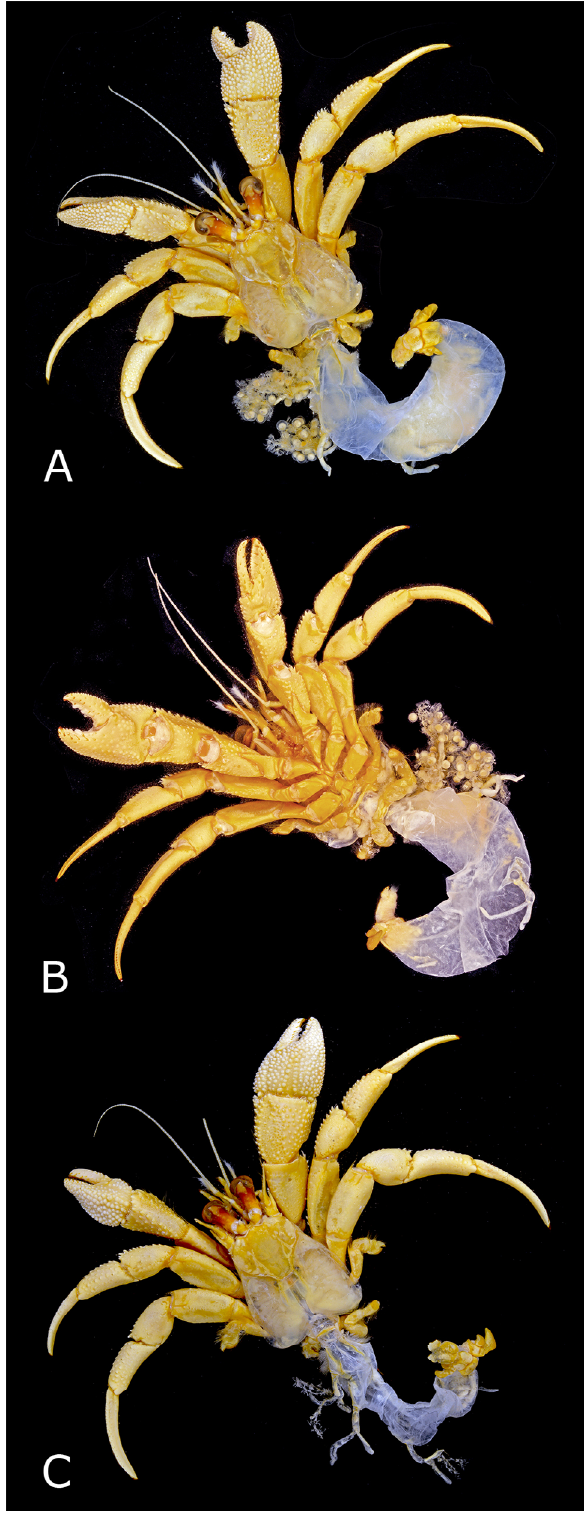
Figure 4. Paratypes of Eupagurus smithii A.